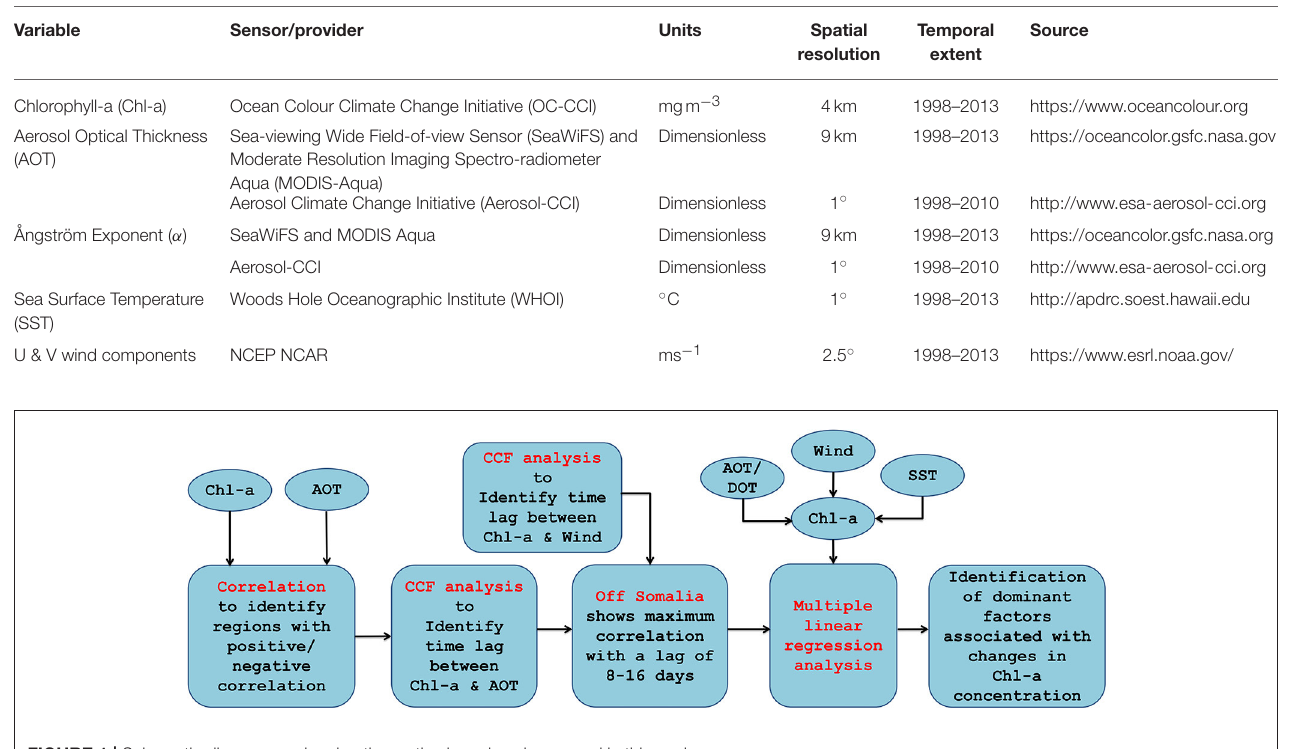
FIGURE 1 | Schematic diagramme showing the methods and analyses used in this work.